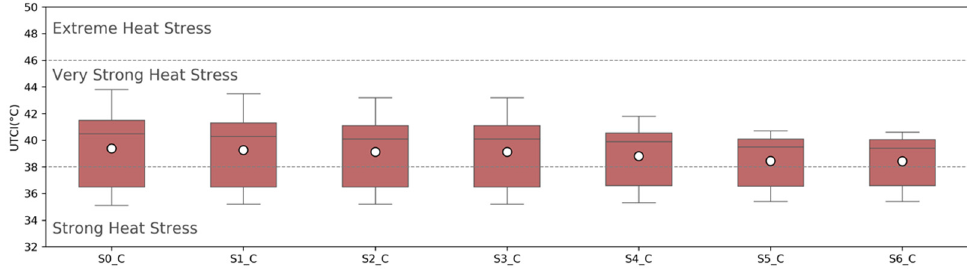
Figure 8. The UTCI level range of scenarios during simulation hours in very deep street canyons (indexed as C).